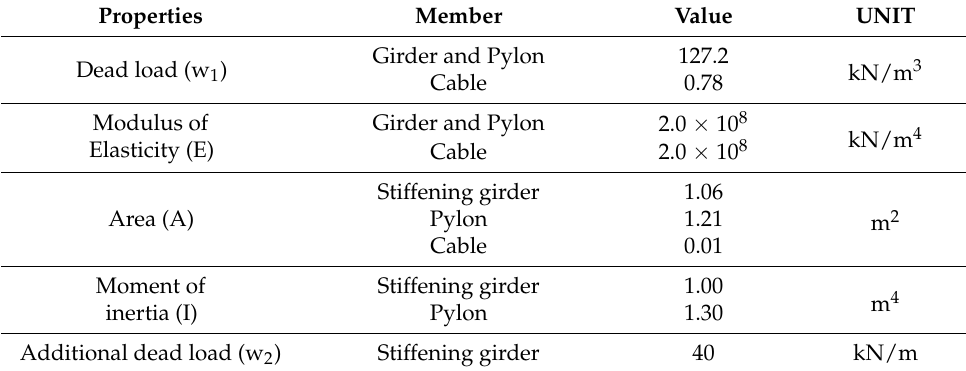
Figure 14. Example bridge layout. Table 1. Material and geometric properties.